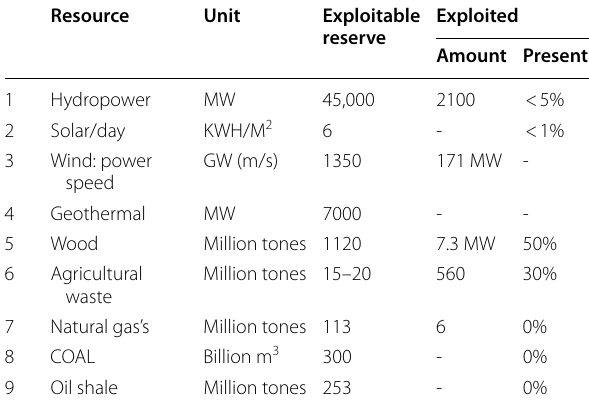
Table 1 Energy Resource Potential of Ethiopia (June 22, 2013) (Derbew 2013)